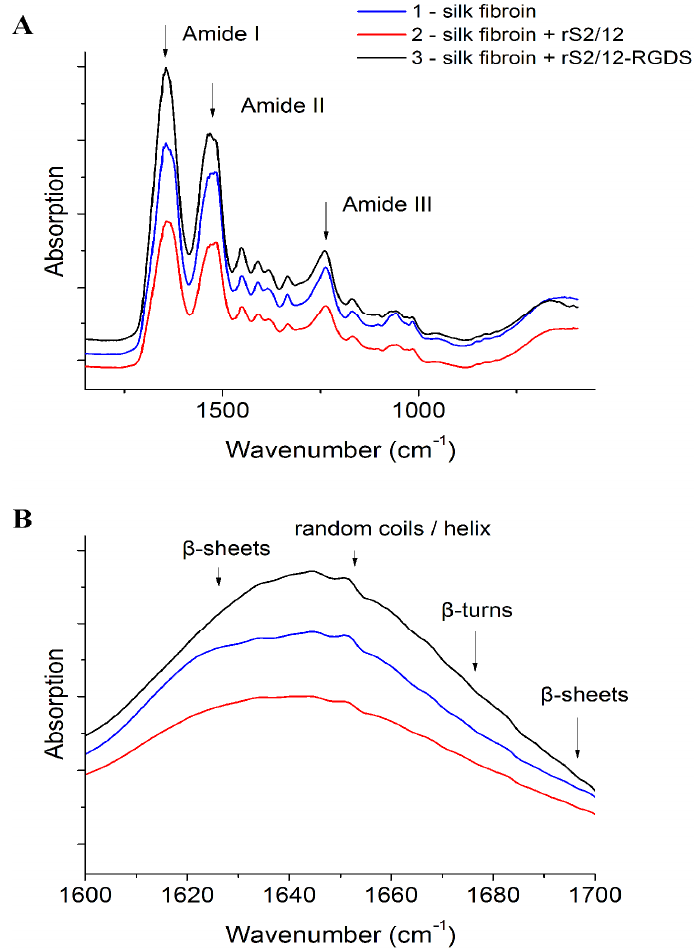
Figure 2. FTIR spectra of silk fibroin and spidroin-based scaffolds ( A ). The region of amide I ( B ) is shown separately.